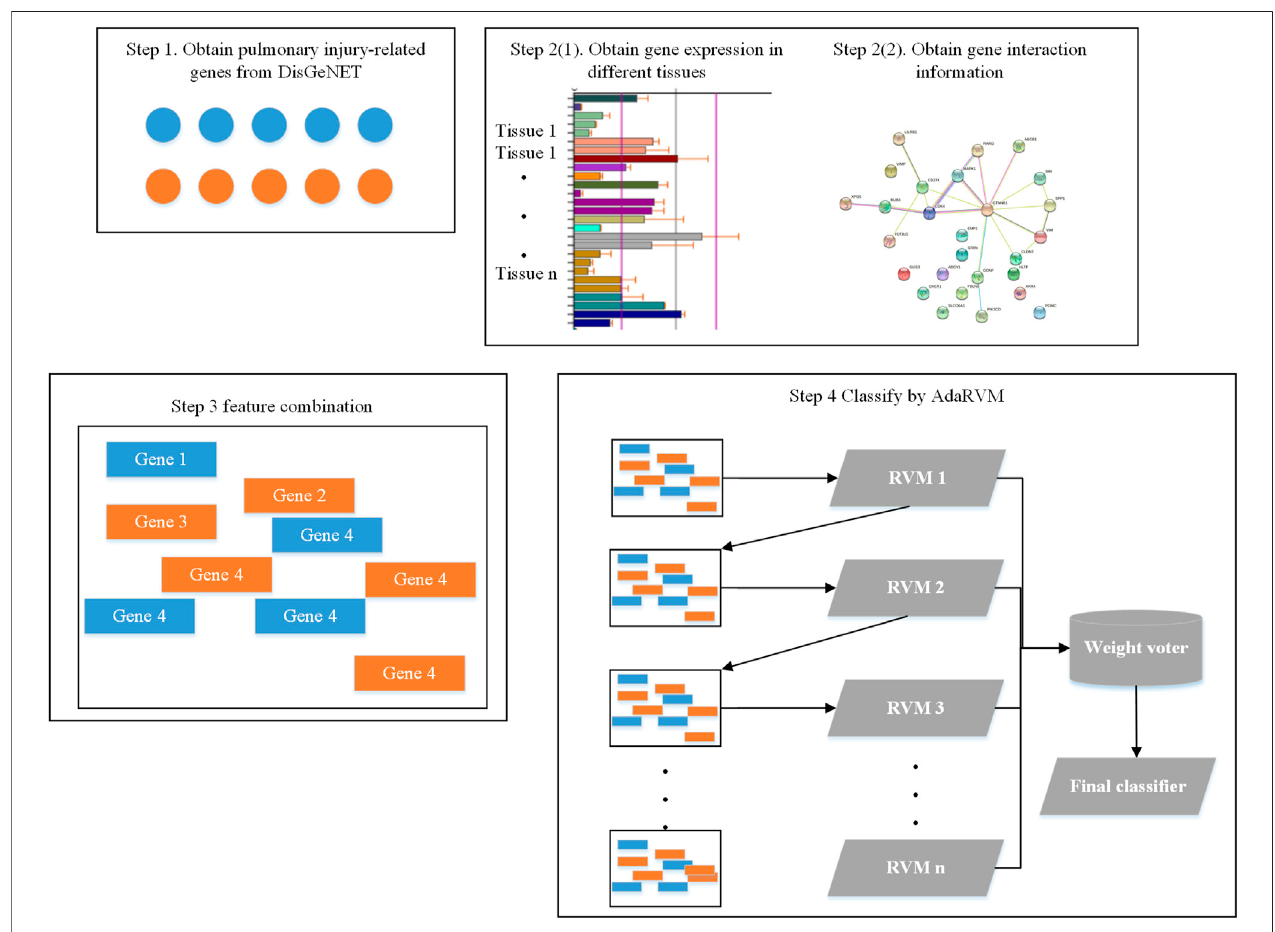
FIGURE 1 | Work fl ow of identifying pulmonary injury-related